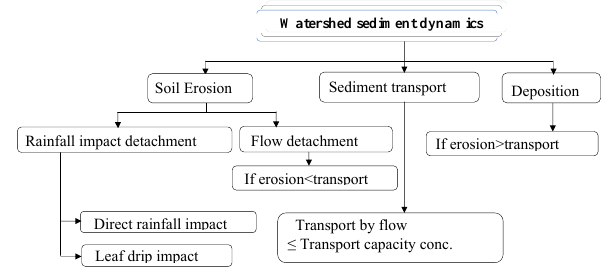
Fig. 1. Process-based approach of watershed sediment dynamics (after Foster, 1982).